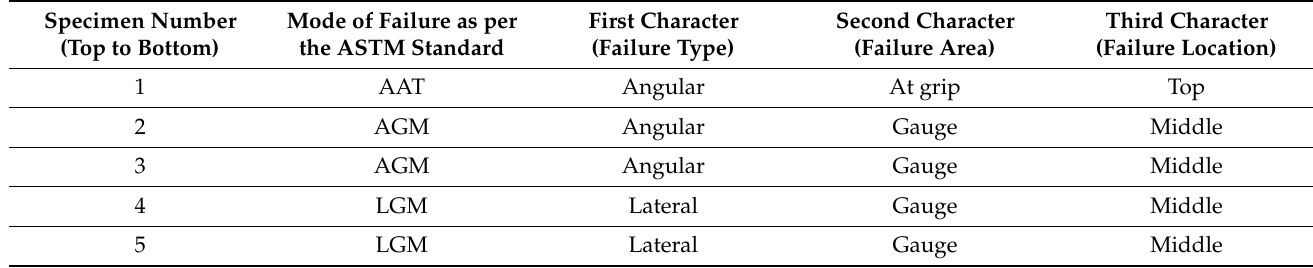
Table 5. Modes of failure—uncarbonised eggshell filled composite specimens.